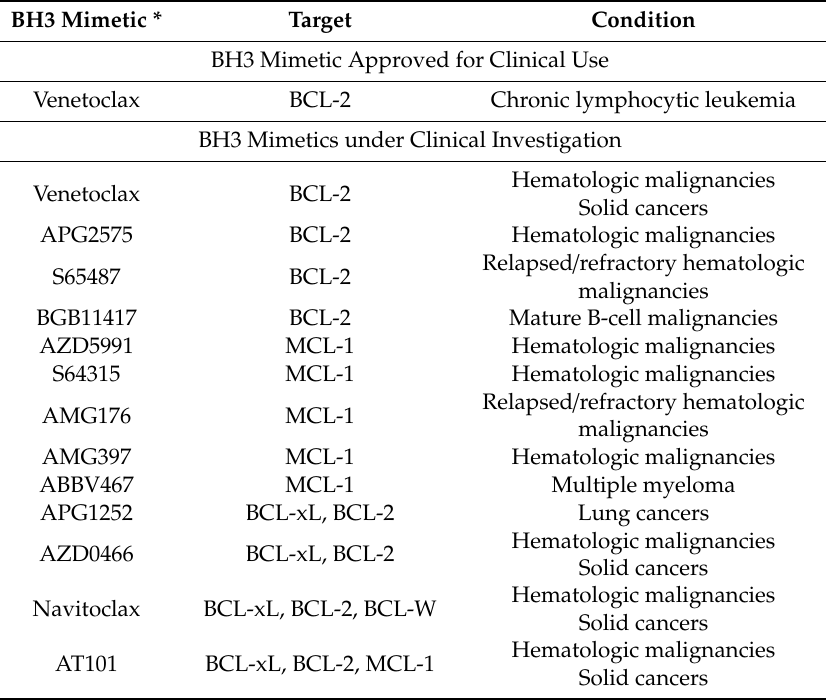
Table 1. BH3 mimetics clinically